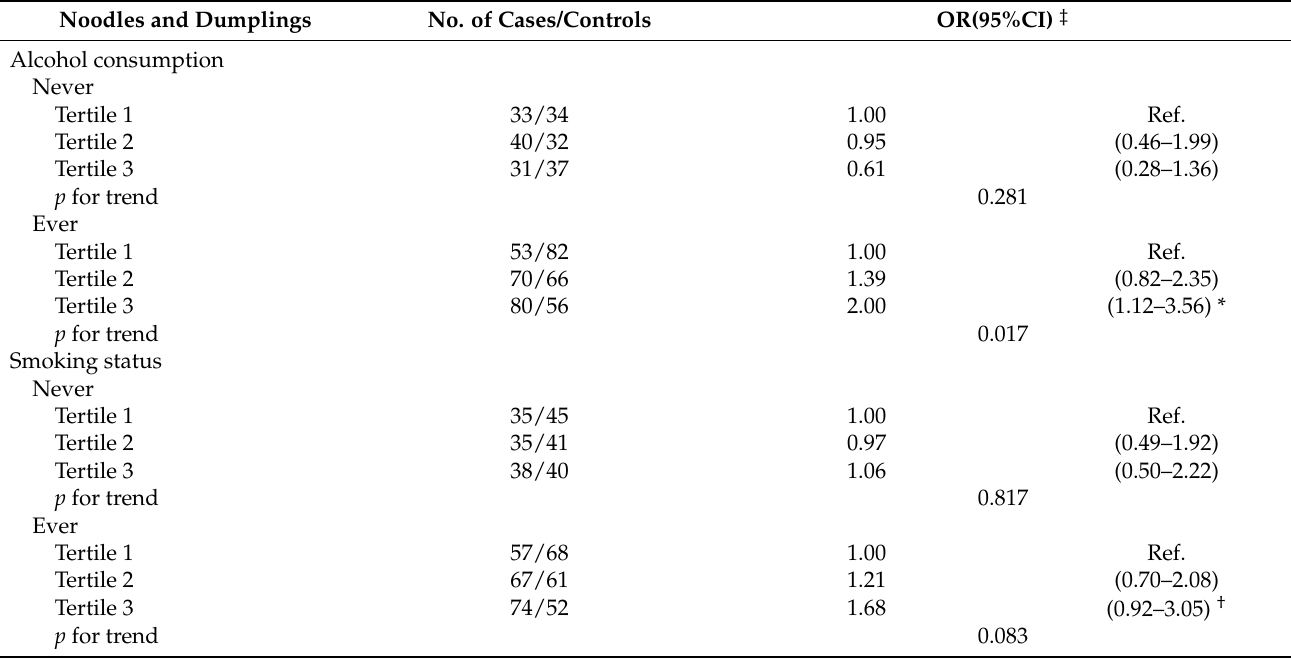
Table 4. Association gastric cancer and intakes of noodles and dumplings according to alcohol consumption or smoking status.